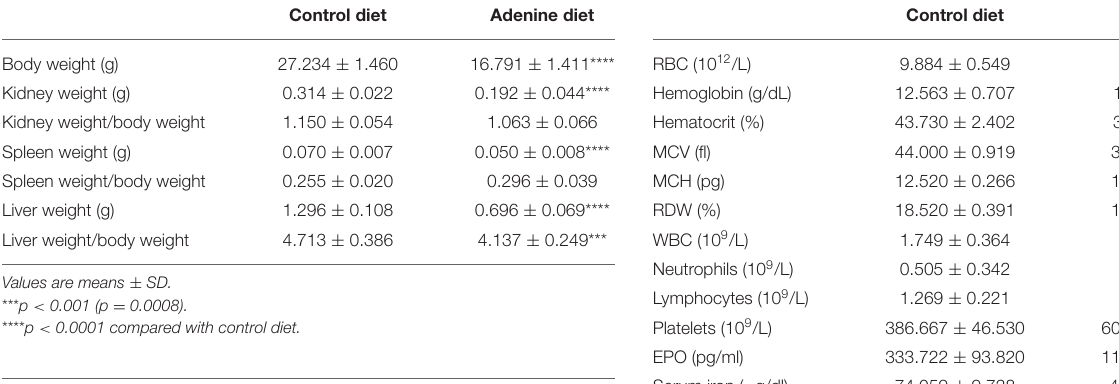
TABLE 2 | Biochemical parameters.